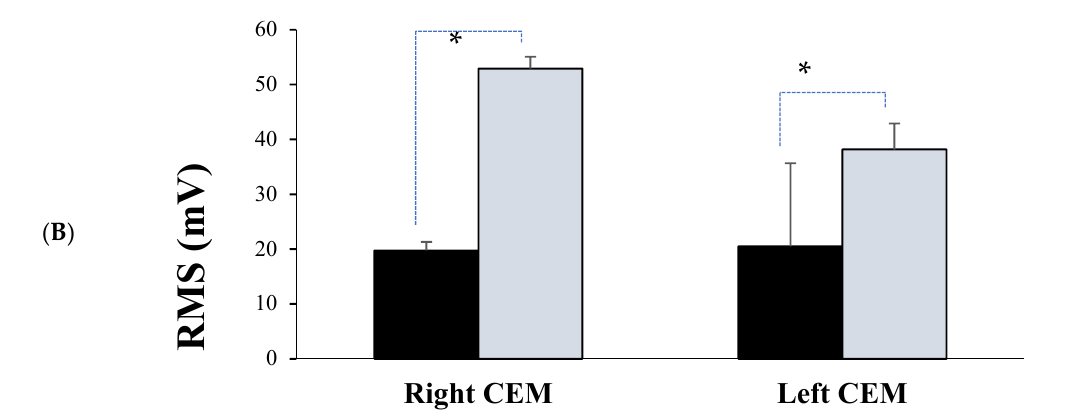
Figure 4. Average ( A ) mean power frequency (MNF), and ( B ) root mean square (RMS) for both right and left CEM during the pre and post fatigue protocol for fatigue group. Significant differences between pre and post fatigue existed for both the MNF and RMS. Error bars represent SD. * p < 0.001.